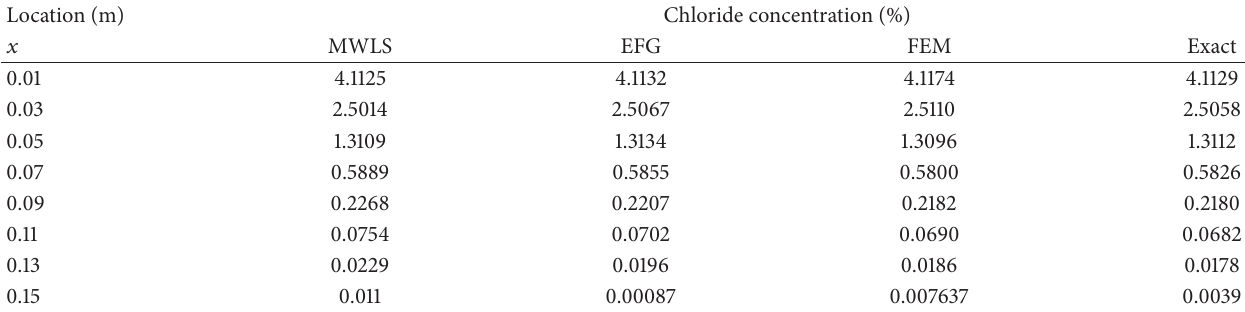
Table 2: Results of MWLS, EFG, and FEM and exact solutions at a few specific locations (31 nodes, 𝑡 = 20 years). Location